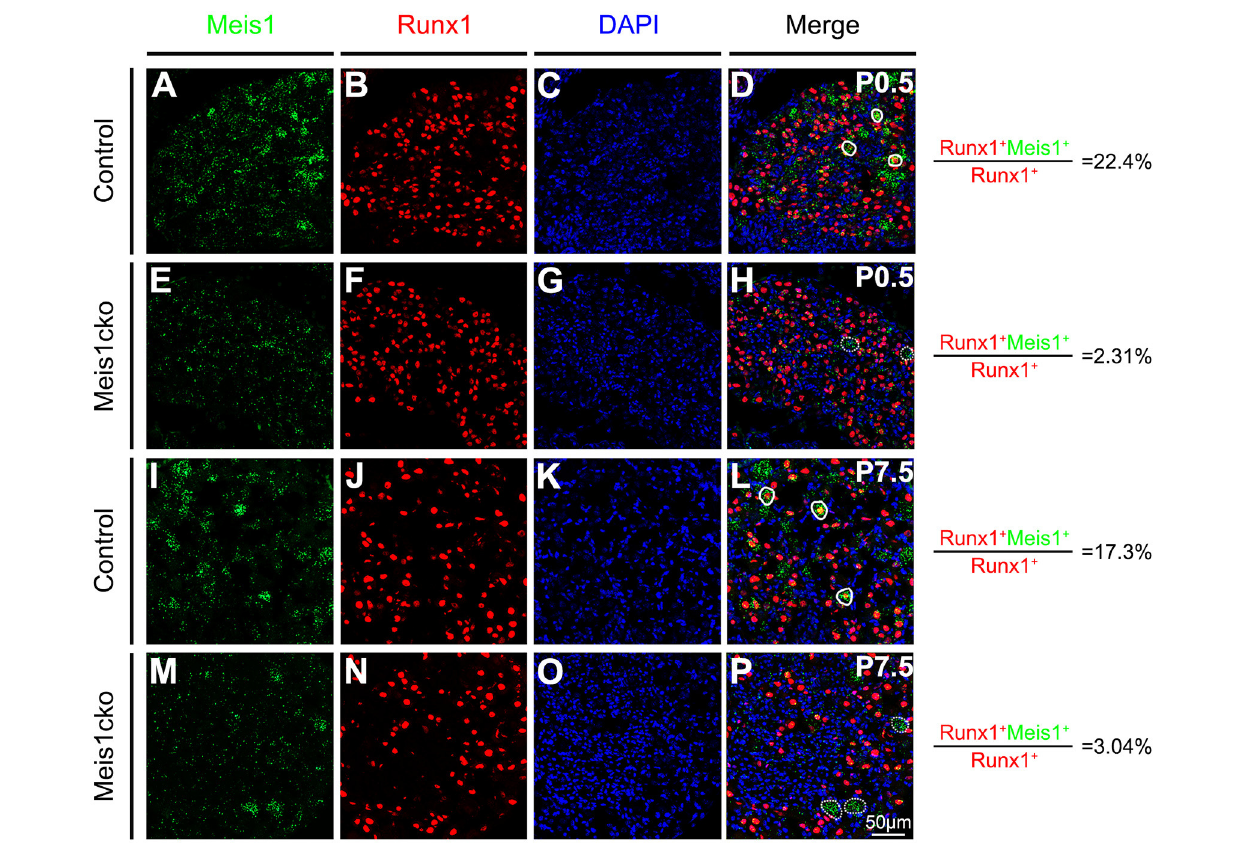
FIGURE 2 | Comparing Meis1 expression between Meis1cko and control DRGs. Representative images of lumbar DRG sections costained with an antibody against the Runx1 protein (red) and Meis1 mRNA (green) in Meis1cko and control mice at P0.5 and P7.5. (A–H) 22.4% (684/3052 in control mice) and 2.31% (42/1818 in Meis1cko mice) of Runx1 + neurons coexpressed Meis1 at P0.5. (I–P) A total of 17.3% (370/2142 in control mice) and 3.04% (33/1086 in Meis1cko mice) of Runx1 + neurons coexpressed Meis1 at P7.5. Solid lines indicate Meis1 + neurons coexpressing Runx1. Meis1 was expressed in large neurons indicated with a dotted line. DAPI-stained cell nuclei appeared blue. Quantitative data are shown to the right of the panels. Scale bar: 50 µ m.